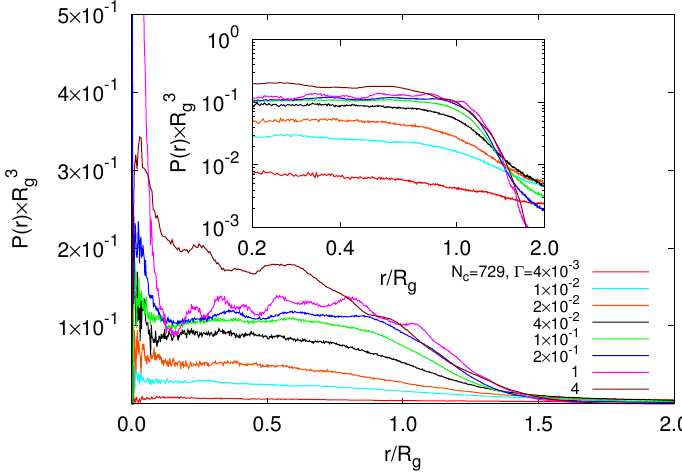
Figure 13. Normalized radial counterion distribution functions P ( r ) , with respect to the microgel center of mass, for various interactions strengths and the microgel of size N c = 729 and L / l = 400. The inset shows the same quantities in a semilogarithmic representation. The radii of gyration of the microgels are R g / l = 56.7, 67.7, 75.1, 77.1, 81.7, 78.2 and 40.2 with increasing Γ